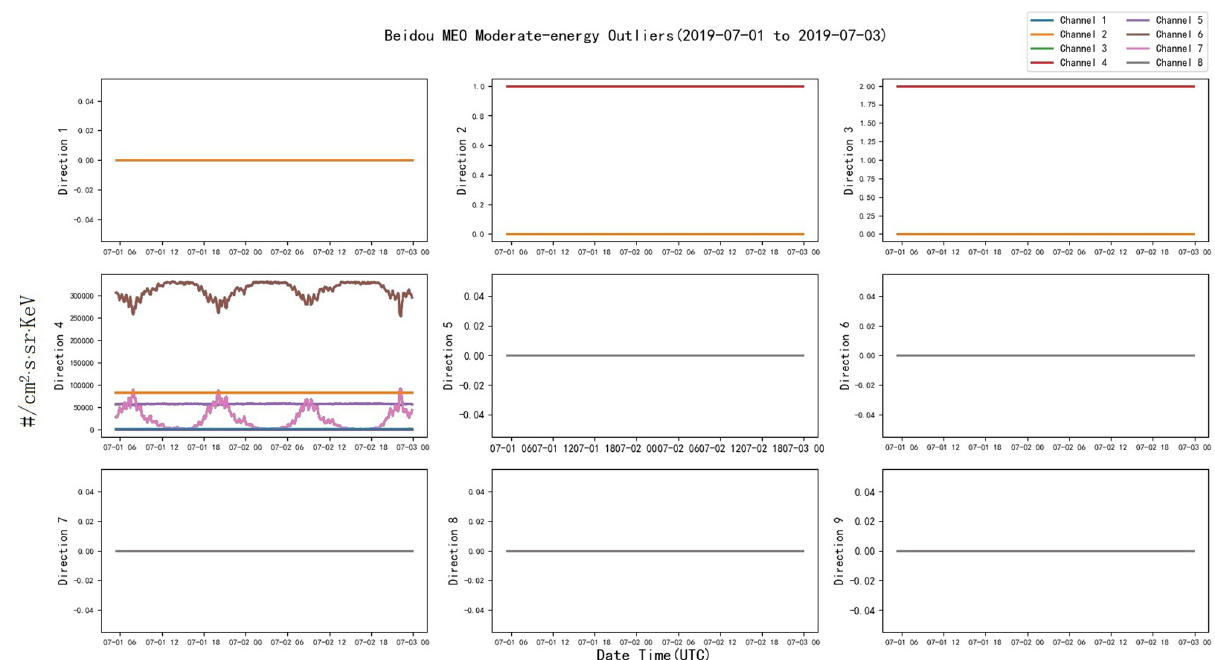
Figure 3: The outliers of BeiDou moderate - energy electron data from July 1 to July 7,